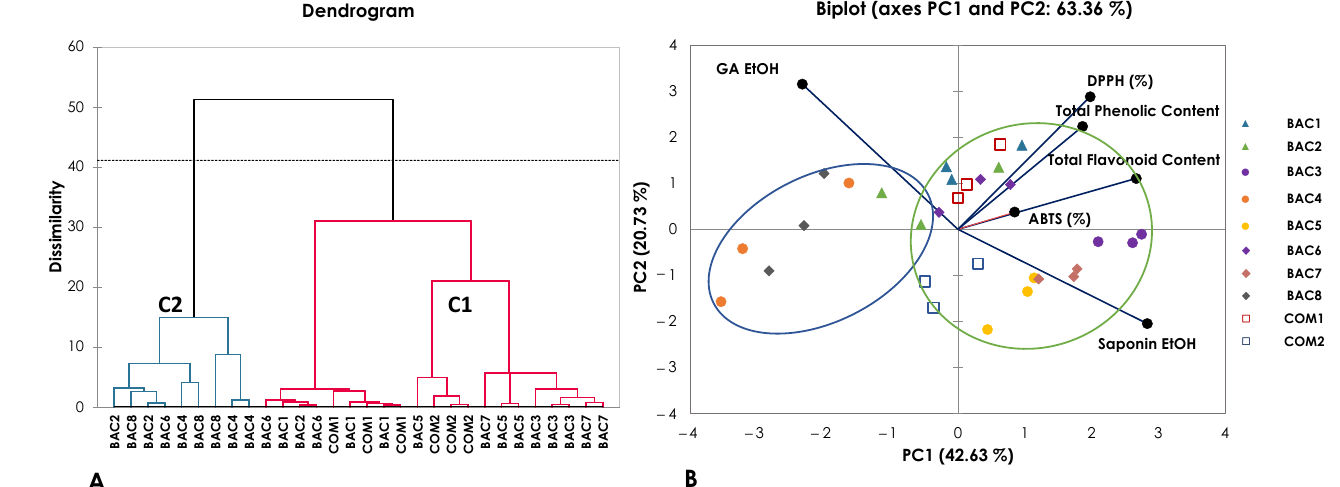
Figure 4. ( A ) The dendrogram of different Gymnema inodorum samples assessed from their phytochemicals. ( B ) The principal component (PC) analysis of the G. inodorum based on their phytochemicals. C1 and C2 represent different clusters displayed on the dendrogram ( A ), and the same clusters (color) are shown in the biplot ( B ). GA; gymnemic acid.